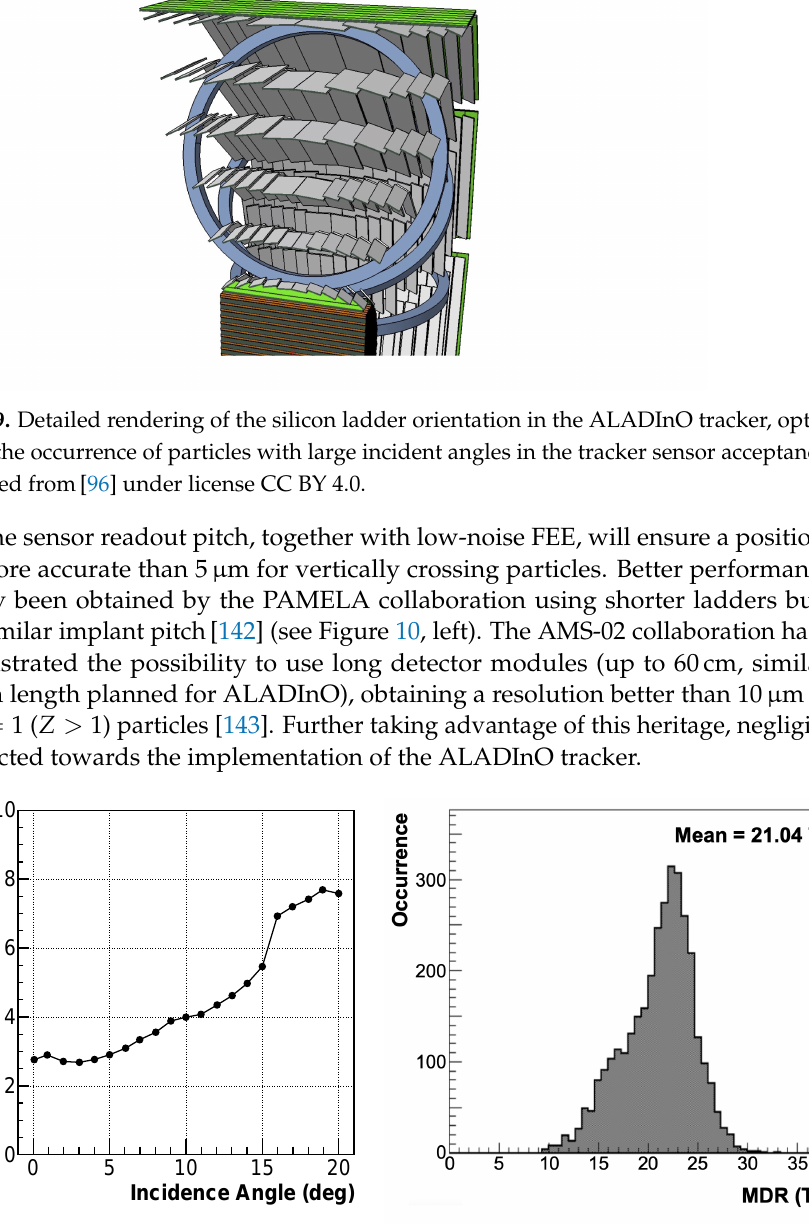
Figure 10. Left: Spatial resolution of the PAMELA tracker short ladders as a function of the particle incident angle. Figure recreated by authors of [142] from original data files, see original paper for details. Right: Distribution of the MDR of the ALADInO spectrometer evaluated with preliminary numerical simulations over a wide range of incident angles. The result confirms the reach of an average MDR larger than 20TV for the expected tracker coordinate